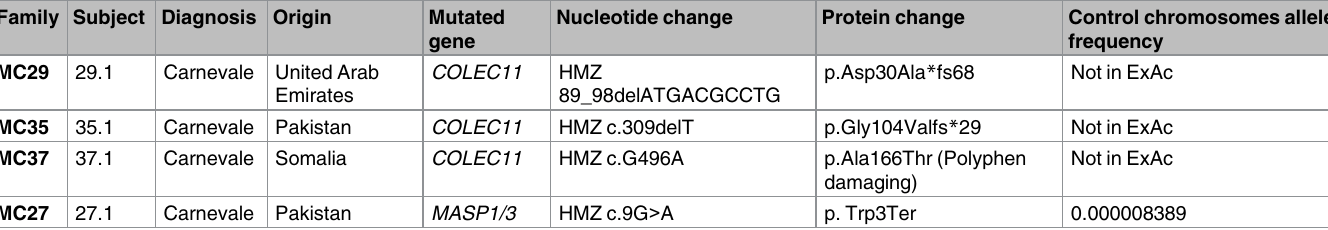
Table 1. New COLEC11 and MASP1/3 mutations in 3MC patient cohort Family Subject Diagnosis